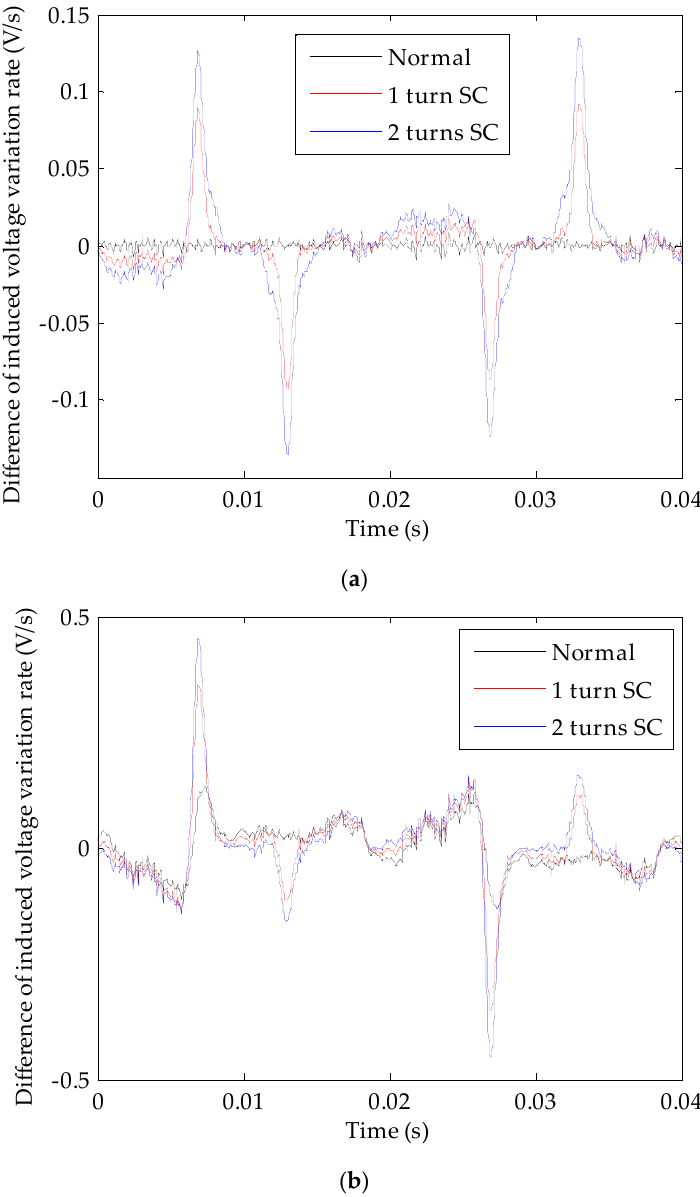
Figure 12. Difference in the induced voltage change rates for both detection coils with different short circuit degrees in winding slot #3: ( a ) no-load; ( b ) rated load.